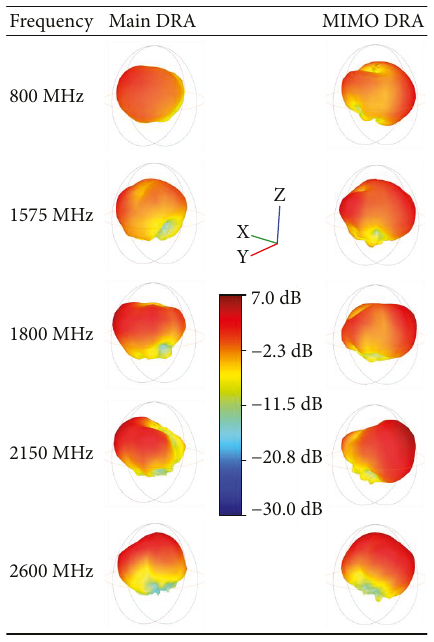
Figure 20: Radiation patterns of the MIMO system in 3D